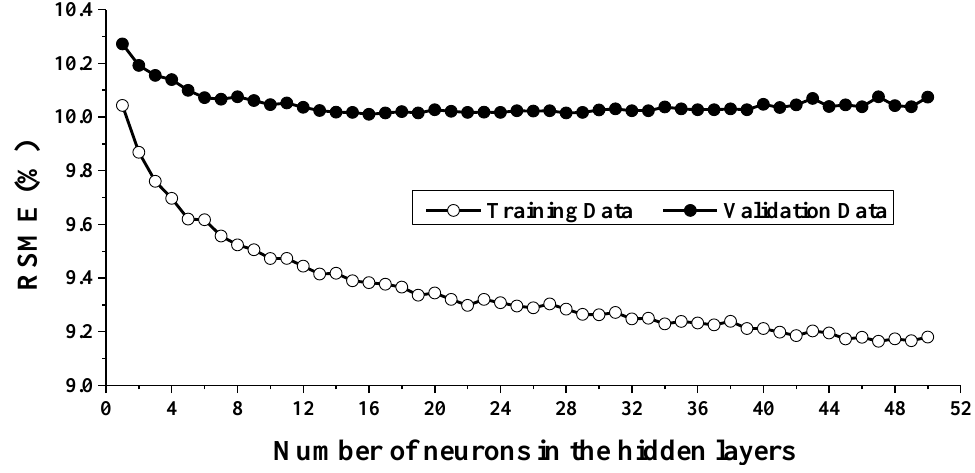
Figure 5. Training and validation errors in the SIP estimation associated with the change of neurons in the hidden layer.